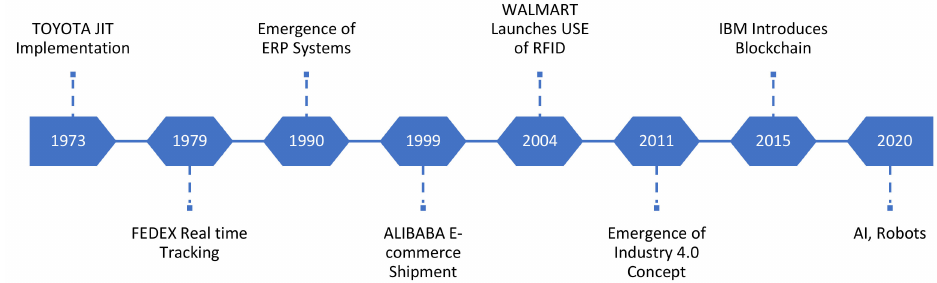
Figure 9. Worldwide historical logistic evolution events.